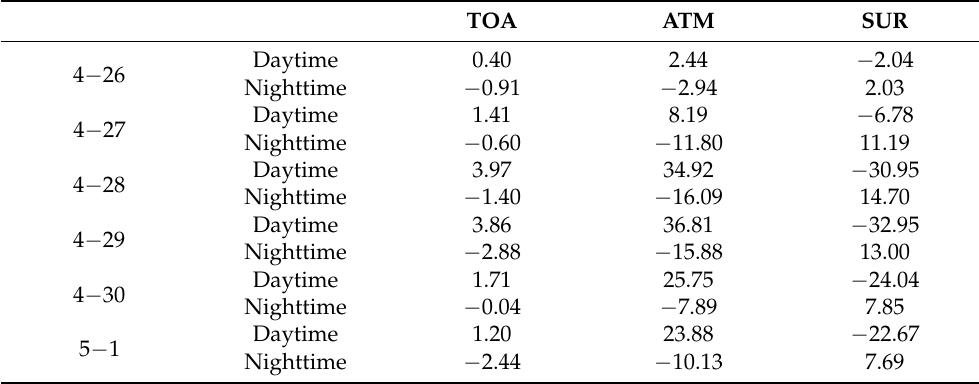
Figure 5. Diurnal variations in the mean net (SW + LW) DDRE over the TB at the top of the atmosphere (TOA: green curve), at the surface (SUR: red curve), and in the atmosphere (ATM: blue curve) in W m − 2 , and diurnal variation in the dust load (dust load: black dotted line) in g m − 2 , averaged over the TB simulated by WRF − Chem from 26 April to 1 May 2015. Table 2. The mean net (SW + LW) DDRE (W m − 2 ) within the TB at the TOA, at the SUR, and in the ATM throughout the selected dust